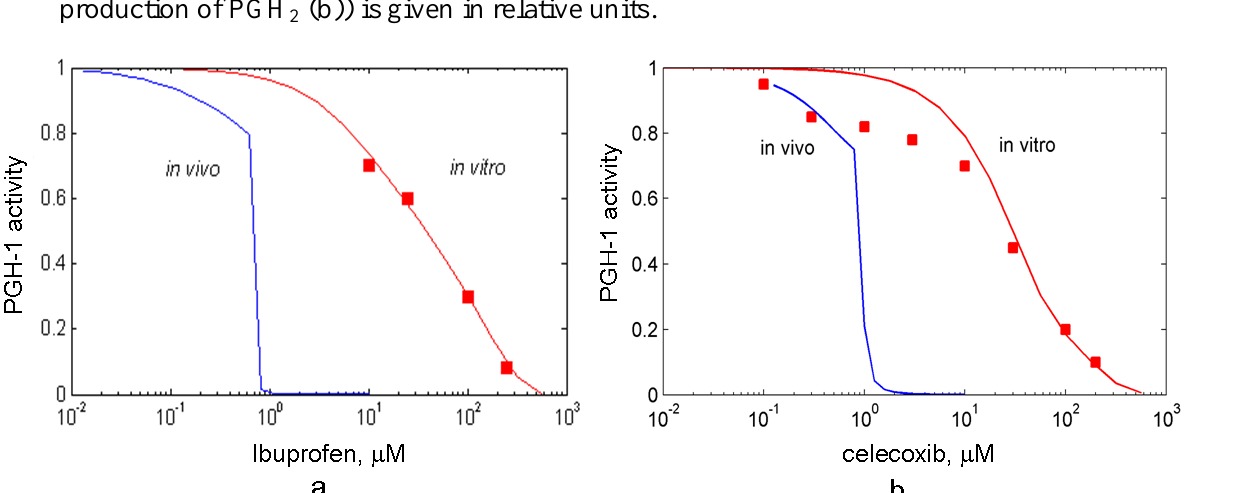
Figure 7. The dose dependencies of PGHS-1 inhibition by celecoxib (a) and ibuprofen (b) calculated for purified (red line) and platelet PGHS-1 (blue line). Points—experimental data for purified PGHS-1 [7]. The enzyme activity (oxygen consumption (a) and (b)) is given in relative production of PGH 2